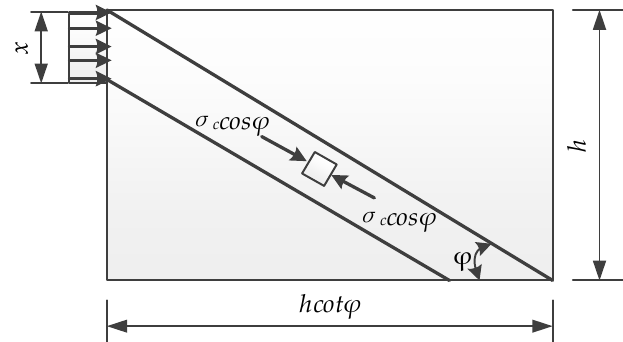
Figure 10. Compressive zone for Truss Model.